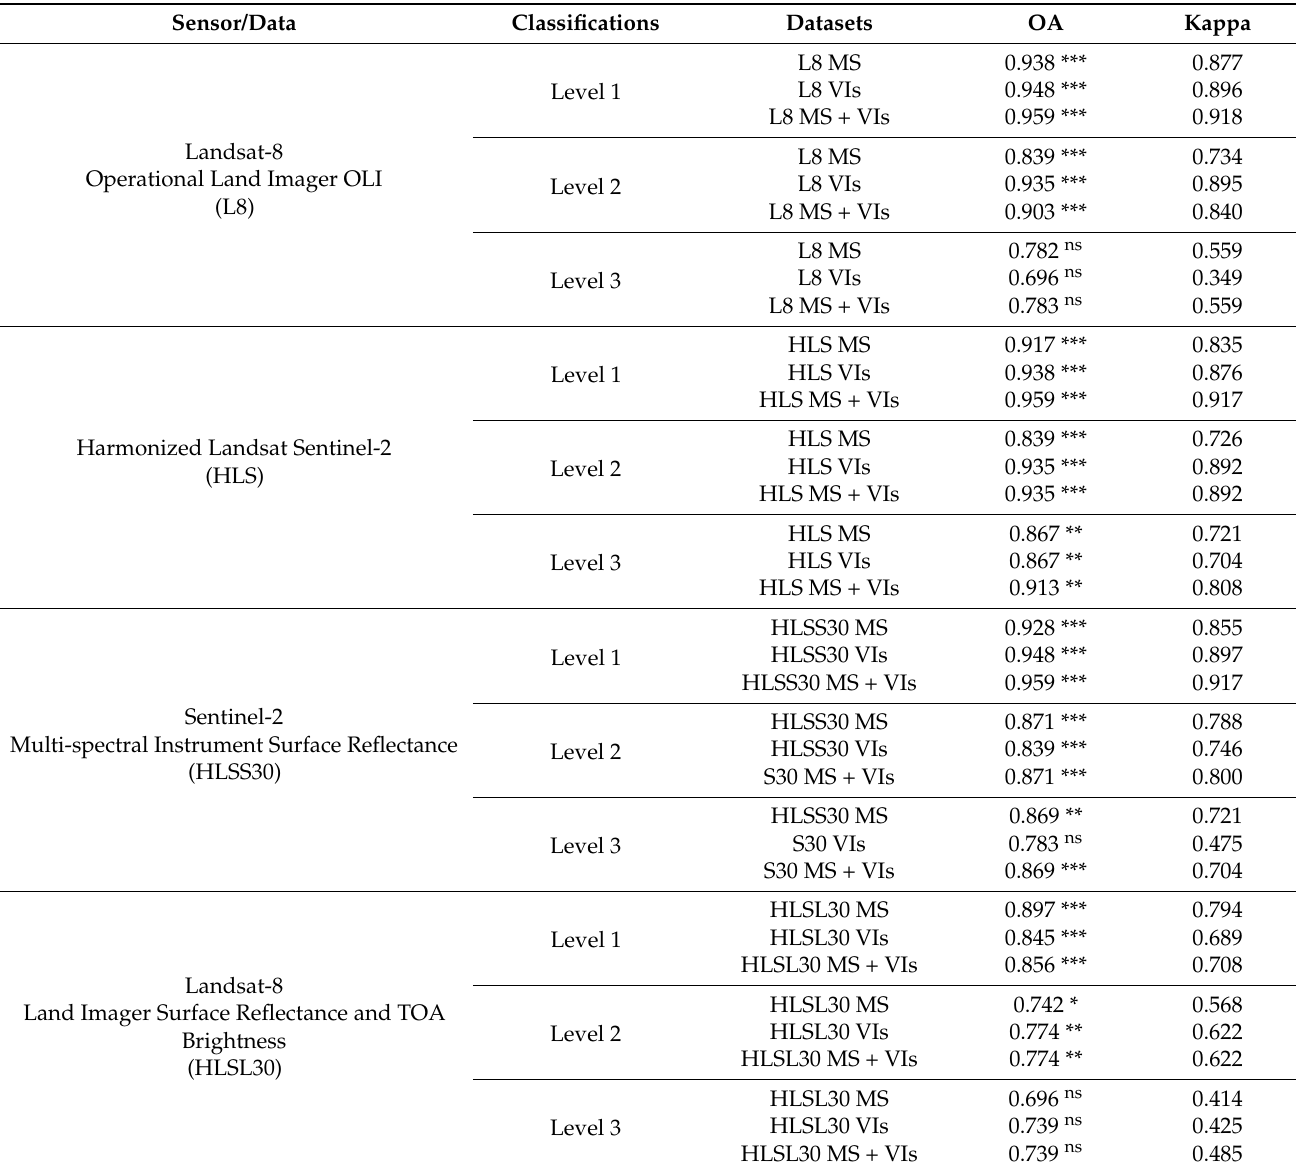
Table 7. Overall Accuracy (OA) and Kappa Index for Level 1, 2, and 3 classifications (L8, HLS, HLSS30, and HLSL30) in datasets: multispectral bands (MS), spectral vegetation indices (VIs), and combination of MS and VI (MS + VIs)